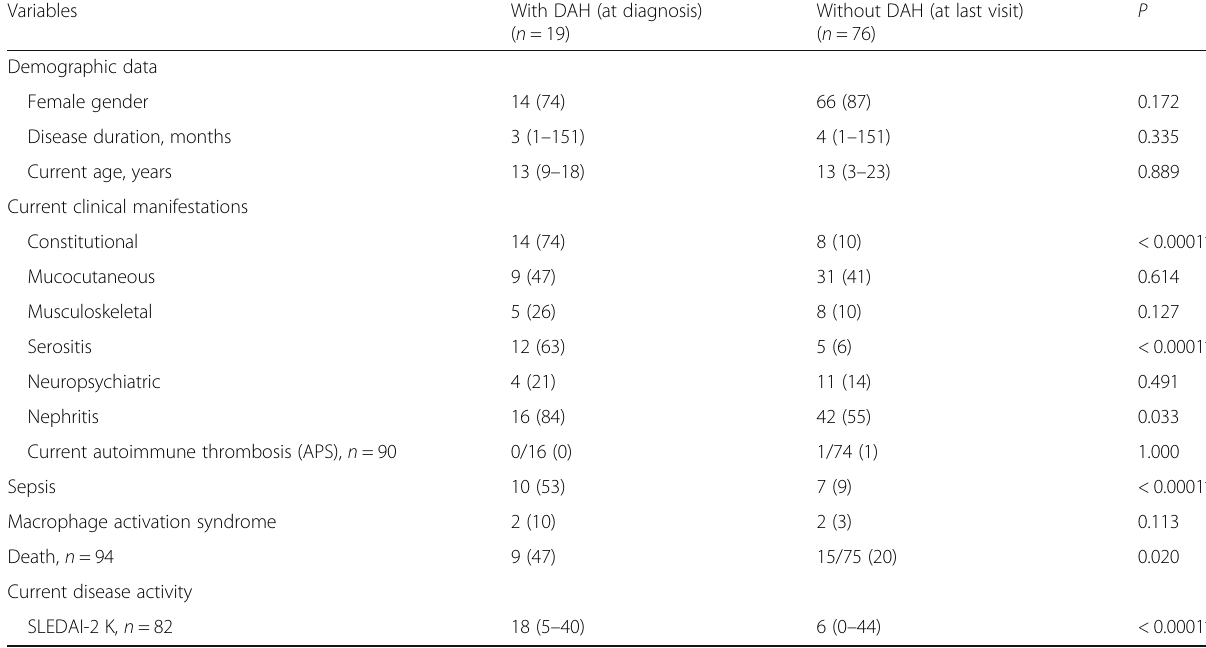
Table 3 Demographic data, clinical manifestations and disease activity score in childhood-onset systemic lupus erythematosus (cSLE) patients according to the presence of diffuse alveolar hemorrhage (DAH)